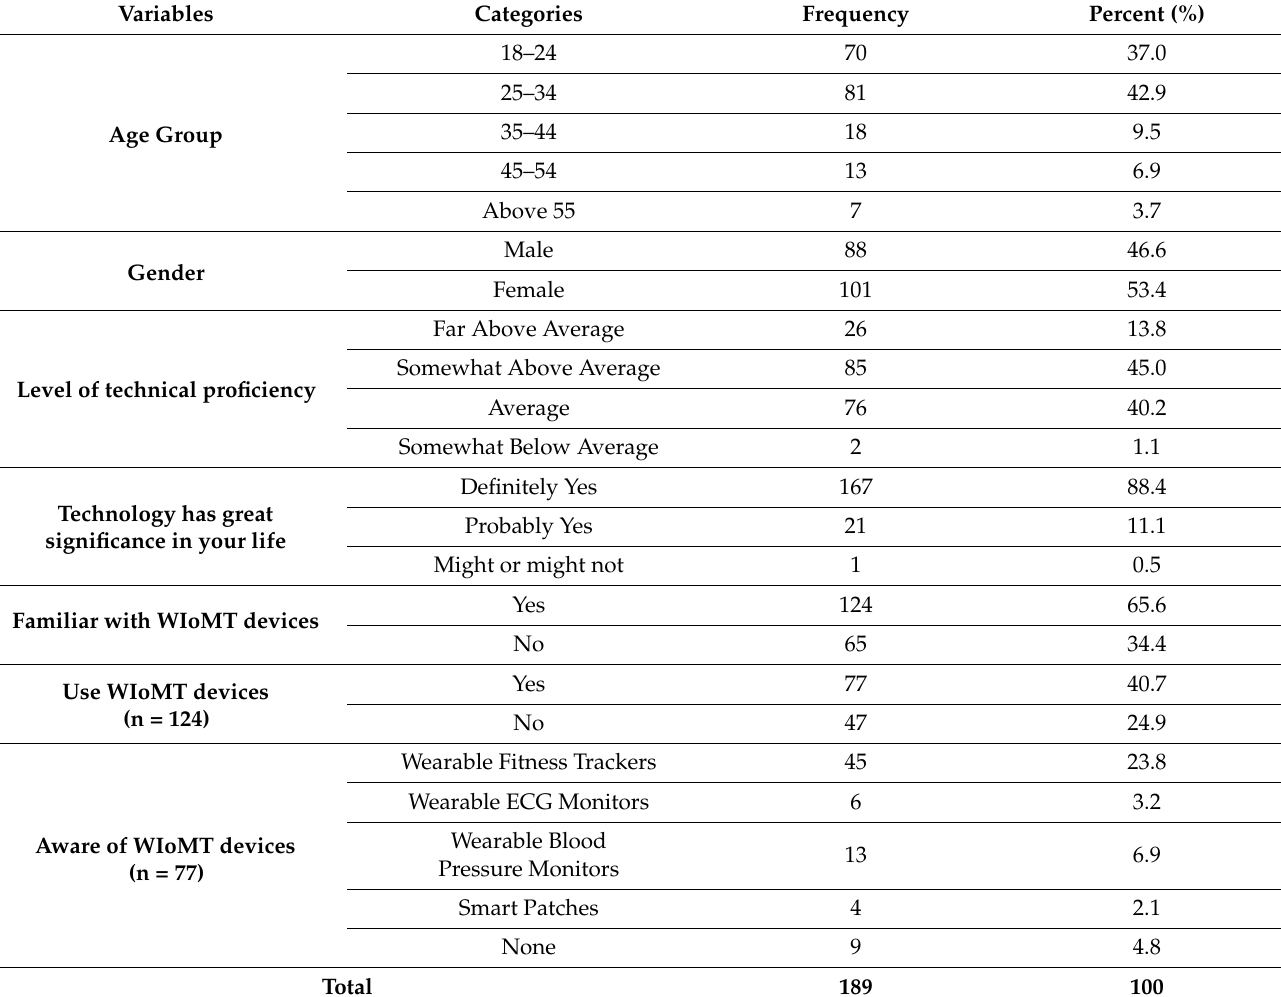
Table 3. Demographic and other characteristics of the respondents (N =